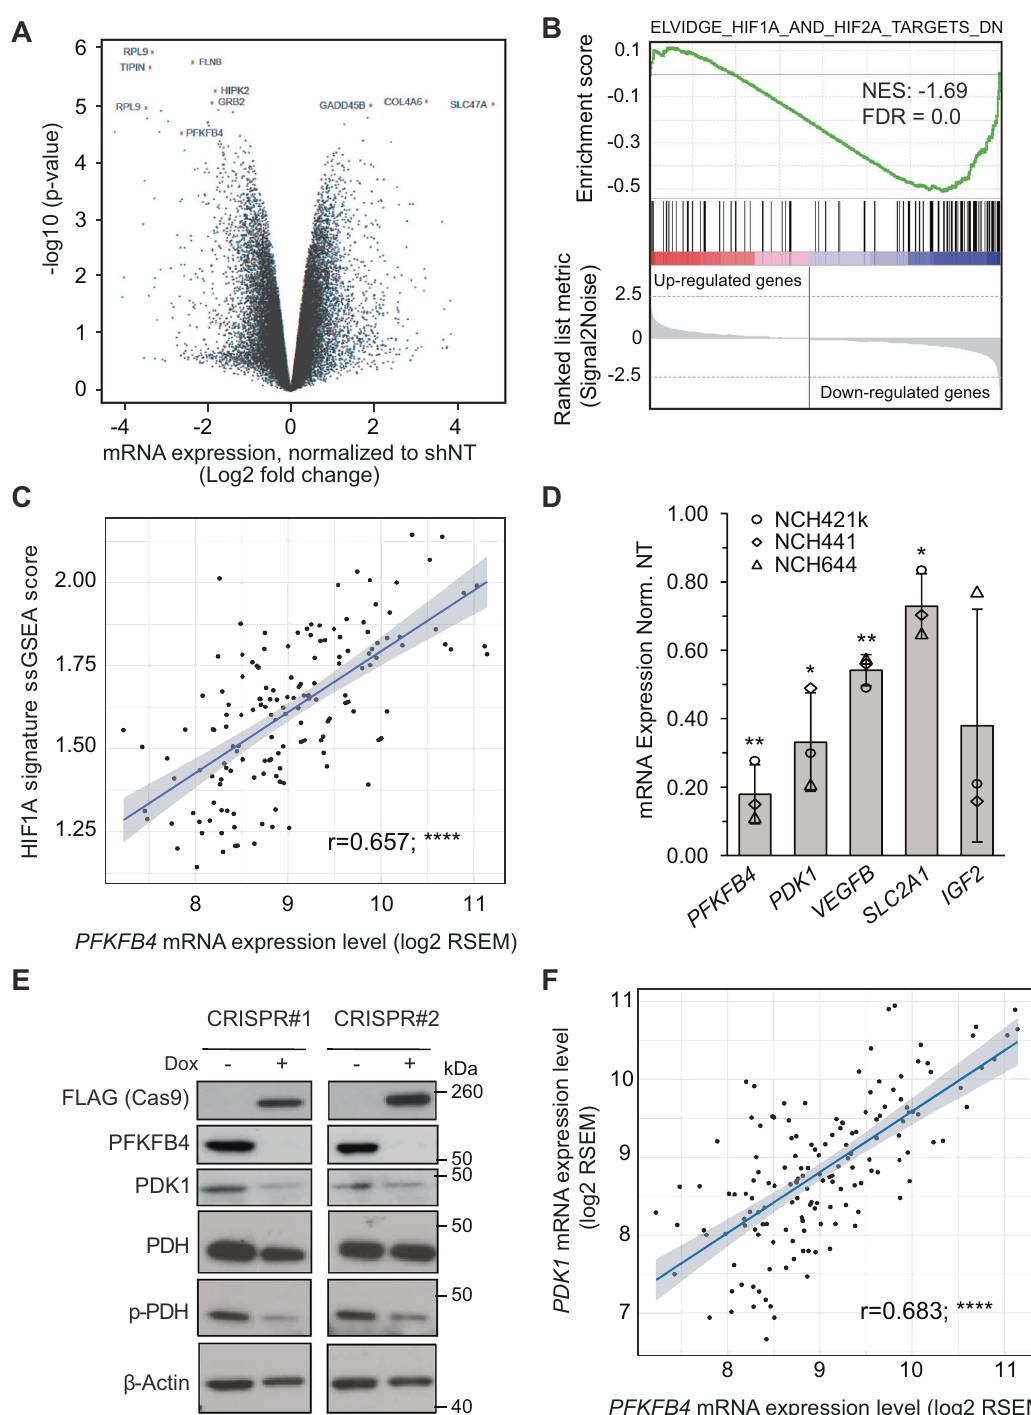
Fig. 2 PFKFB4 regulates the transcription factor HIF-1 α . A Volcano plot showing the fold changes and p -values of gene expression in PFKFB4- silenced (3 days) GSCs. Data represent mean of the three different patient-derived GSC lines: NCH421k, NCH644 and NCH441. Along with PFKFB4 itself, the top 10 deregulated probes are highlighted in red and labelled with the gene to which they map. B Gene Set Enrichment Analysis (GSEA) comparing a gene signature of downregulated genes in a HIF1A / HIF2A -silenced breast cancer cell line (from ref. [27], Elvidge) to the gene expression list of PFKFB4 -silenced GSCs in a rank order based on the mean linear fold change of the genes. The green curve corresponds to the running sum of the enrichment score which re fl ects the degree to which the gene signature is overrepresented at the bottom of the list. (Normalized enrichment score (NES) = − 1.69, false discovery rate (FDR) = 0.0). C Correlation between PFKFB4 mRNA expression and expression of the Elvidge HIF1A gene signature based on its single sample gene set enrichment analysis (ssGSEA) score in TCGA glioblastoma patients (regression analysis, r = 0.657, ****